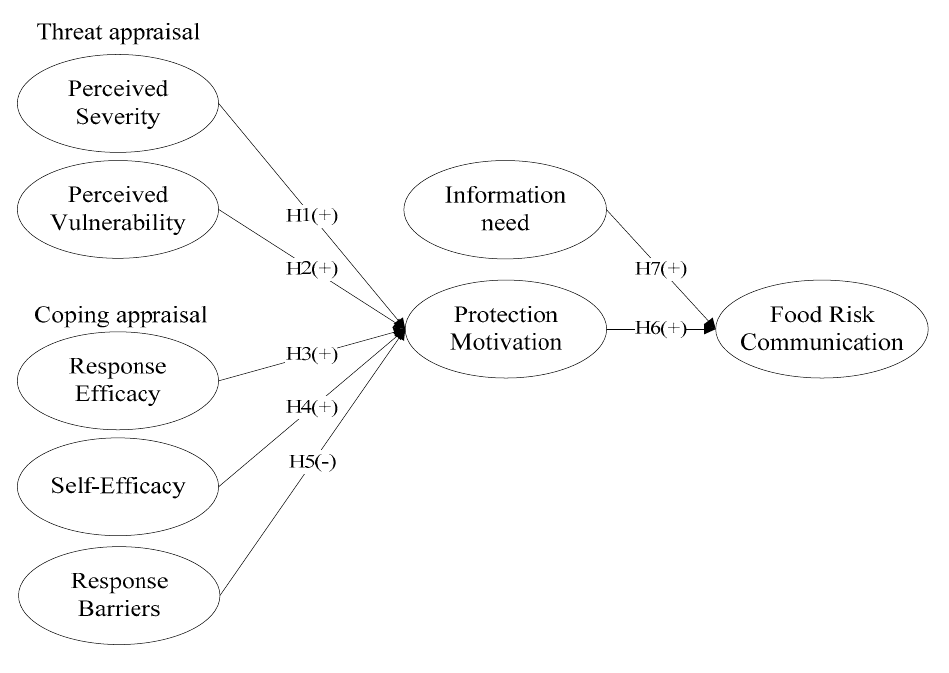
Figure 1. Research model.